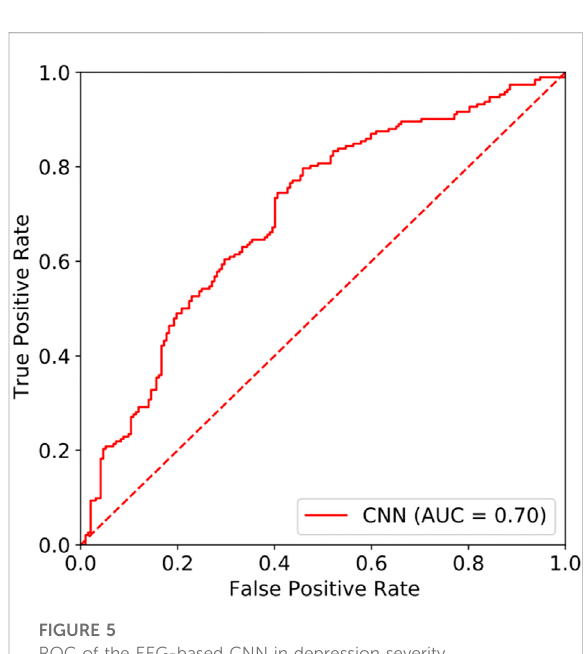
FIGURE 5 ROC of the EEG-based CNN in depression